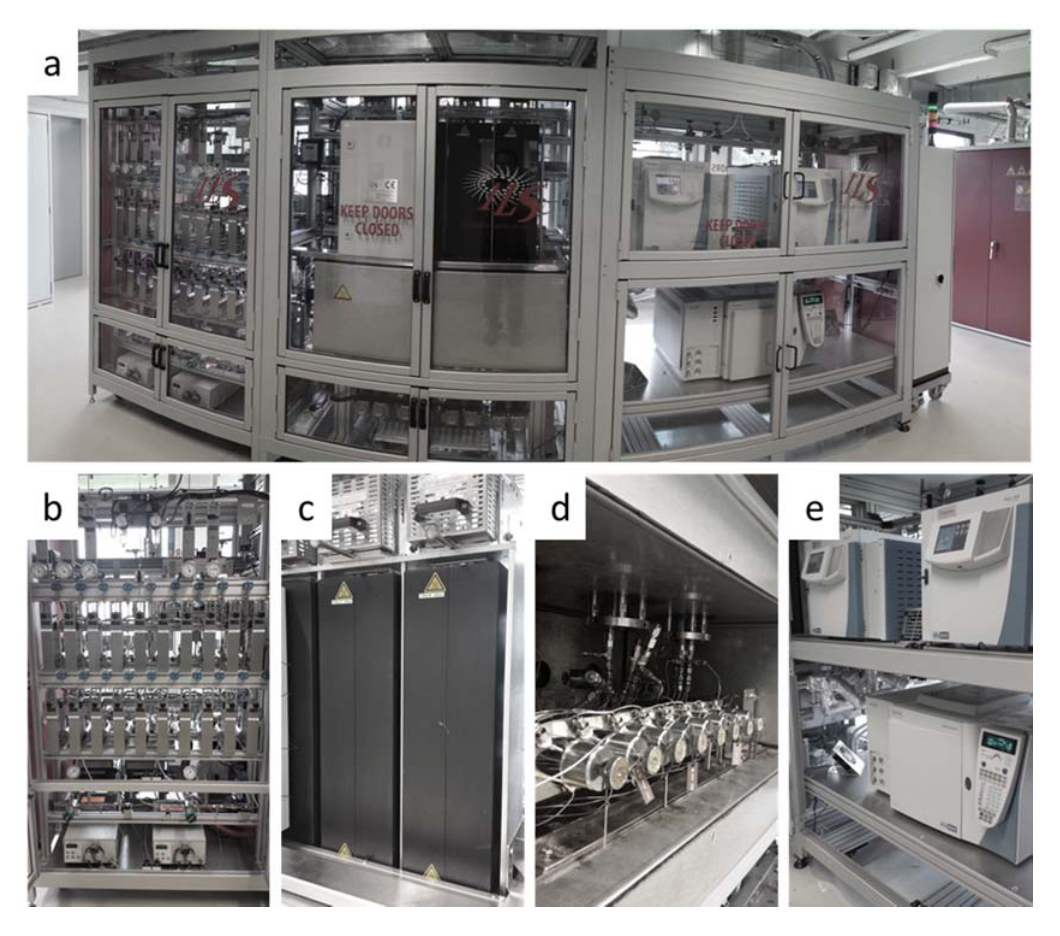
Figure 3. HTK-S set-up pictures: ( a ) front view; ( b ) gas ( top ) and liquid ( bottom )